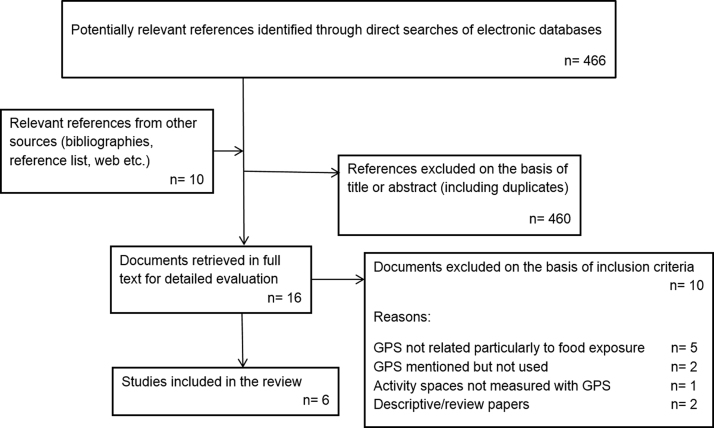
Study flowchart.